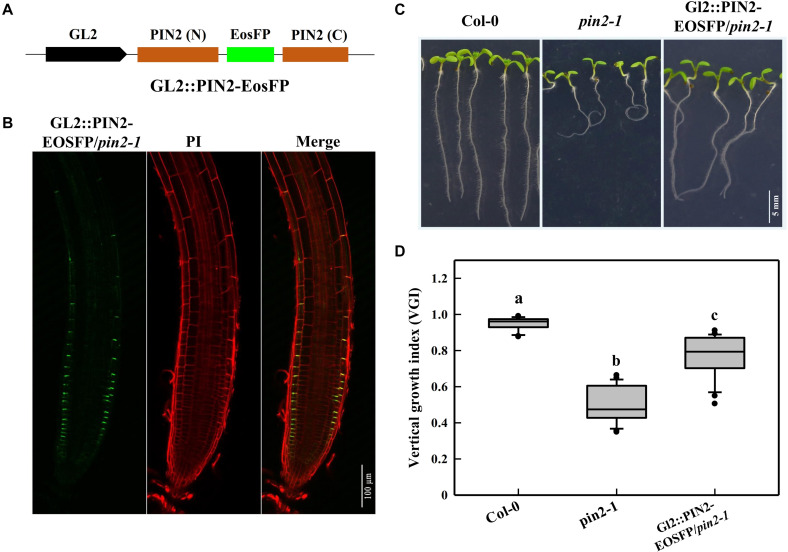
Root VGI of the Col-0, pin2-1 and a partial recovery line GL2:PIN2-EosFP/pin2-1. (A) Schematic map of the GL2:PIN2-EosFP construct. GL2 represents the promoter of GL2, which is expressed specifically in the root epidermis. The fluorescent tag EosFP was inserted between the N and C-terminus of PIN2 CDS. The construct was introduced into pin2-1 mutant lines to generate a partial recovery line, GL2:PIN2-EosFP/pin2-1. (B)
PIN2 expression pattern in GL2: PIN2-EosFP/pin2-1. (C) Representative seedlings of Col-0, pin2-1 and GL2:PIN2-EosFP/pin2-1. Seven-d-old seedlings are shown in the images. (D) The box plot shows the root VGI of Col-0, pin2-1 and GL2:PIN2-EosFP/pin2-1. n > 30 for each bar.